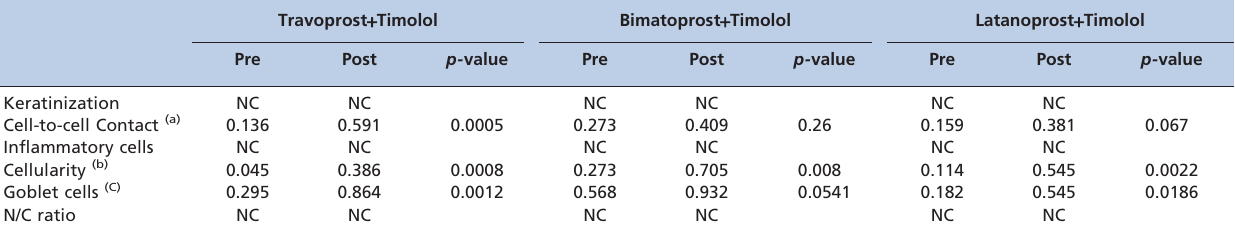
Table 3 - Impression cytology scores. Several parameters were analyzed, but significant differences after three months of treatment were only found in: (a) cell-to-cell contact in the TT group; (b) cellularity in all of the groups; and (c) number of goblet cells in the TT and LT groups. NC: not counted.